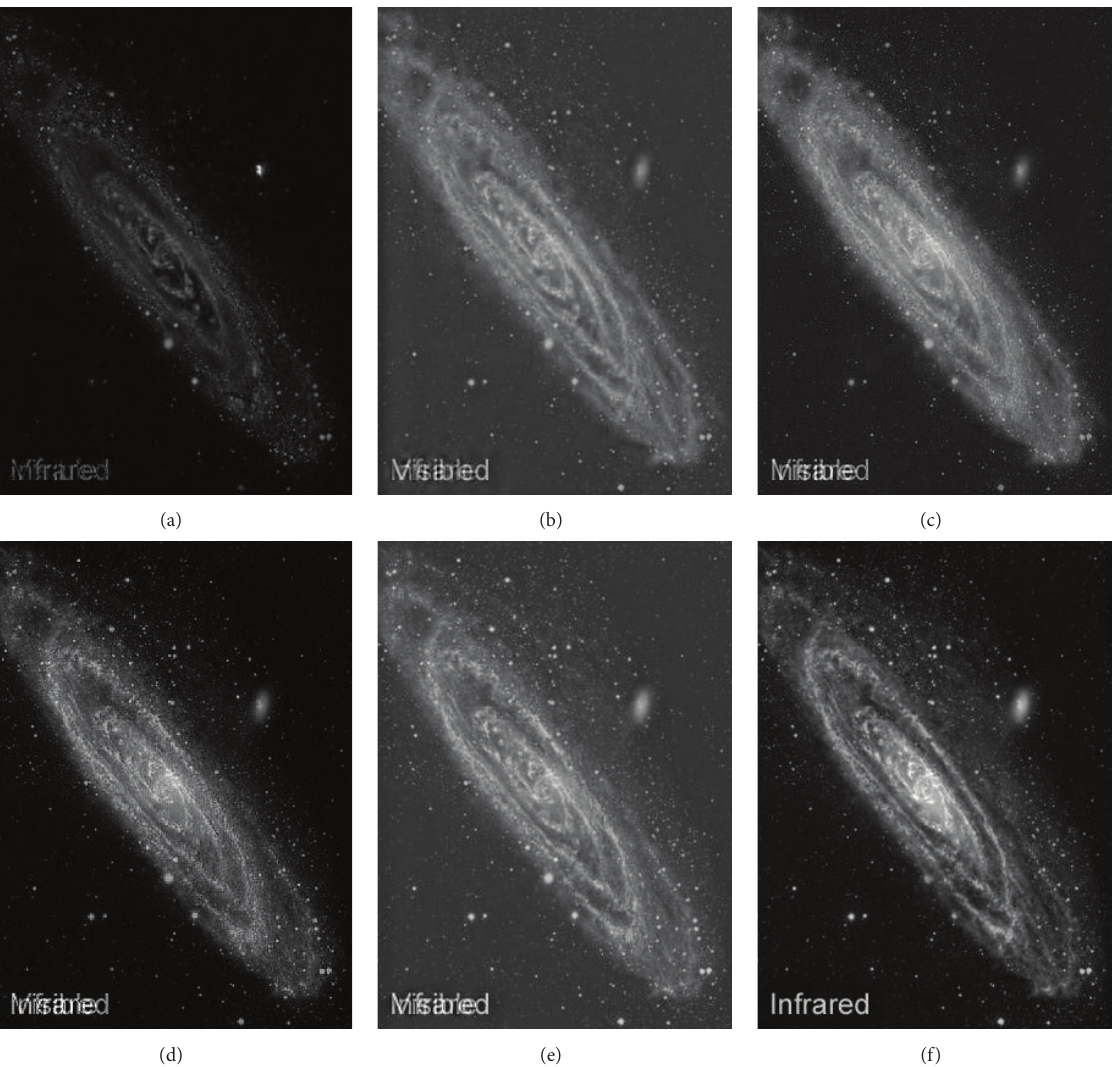
Figure3:Andromedagalaxy(M31):(a)RP[25]fusion,(b)DTCWT[26]fusion,(c)NSCT[27]fusion,(d)MSVD[28]fusion,(e)Ellmauthaler et al. [8] fusion, and (f) proposed